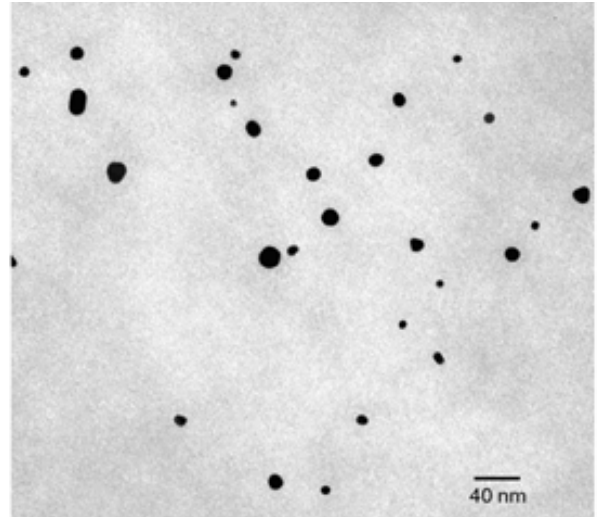
Figure 14. Bright-field transmission electron micrograph of Au/PVAl film irradiated for 5